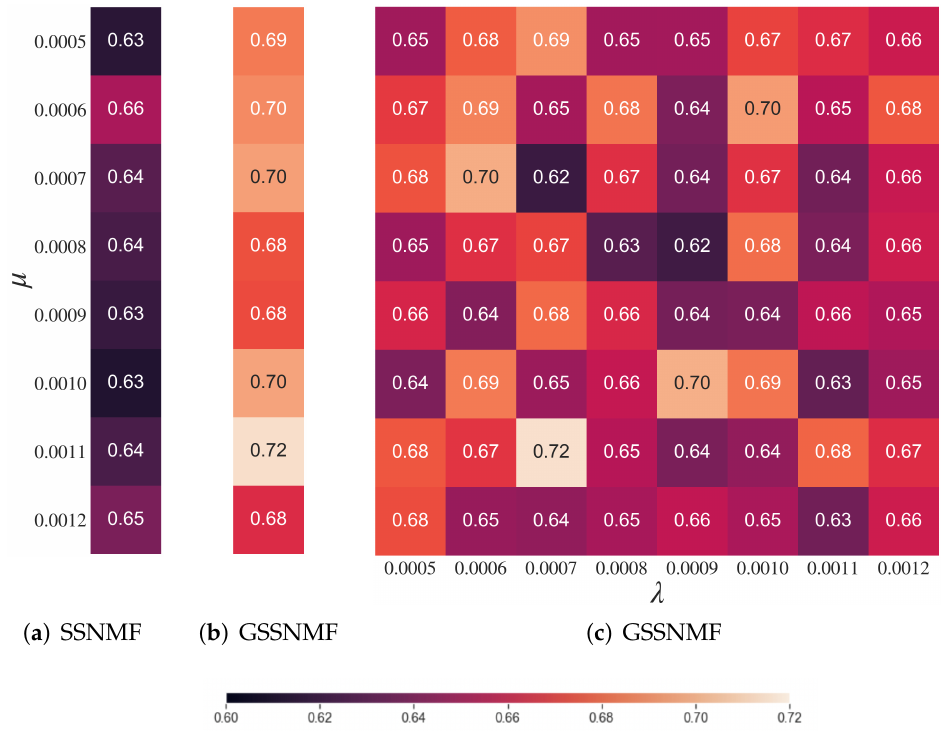
Figure 2. The heatmap representation of Macro F1-score averaged over 10 independent trials with µ , λ 0.005,0.006, ,0.0012 : ( a ) displays the results for SSNMF with ∈ { · · · } µ 0.005,0.006, ,0.0012 ; ( b ) highlights the best scores for GSSNMF by ranging λ from 0.0005 ∈ { · · · } to 0.0012; ( c ) shows the performance of GSSNMF with different values of µ and λ in the predefined range. From the heatmap, one can see, for different µ , that one may choose λ such that GSSNMF outperforms SSNMF.